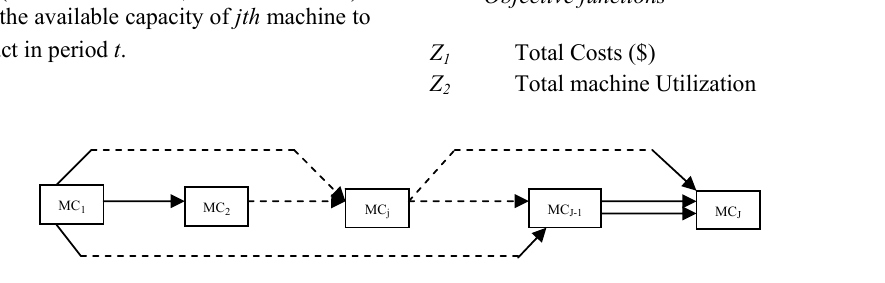
Fig. 2. Multi-Product production